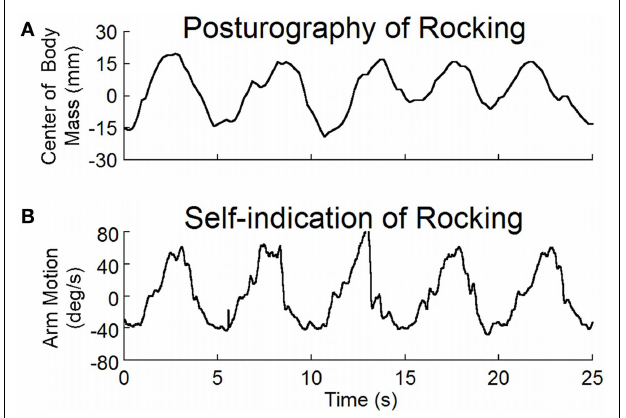
FIGURE 2 | (A) Posturographic recordings of body rocking, and (B) recordings of arm movements at the perceived frequency of rocking. Both body movement and arm movement were at the same frequency of about 0.2Hz.